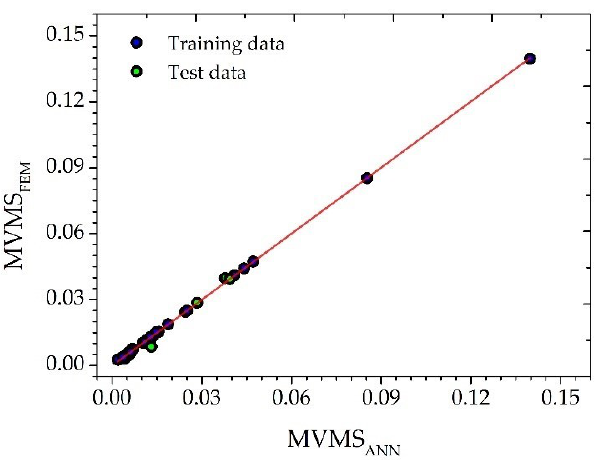
Figure 6. Comparison of FEM and ANN values of MVMS for absorbable mini screw.